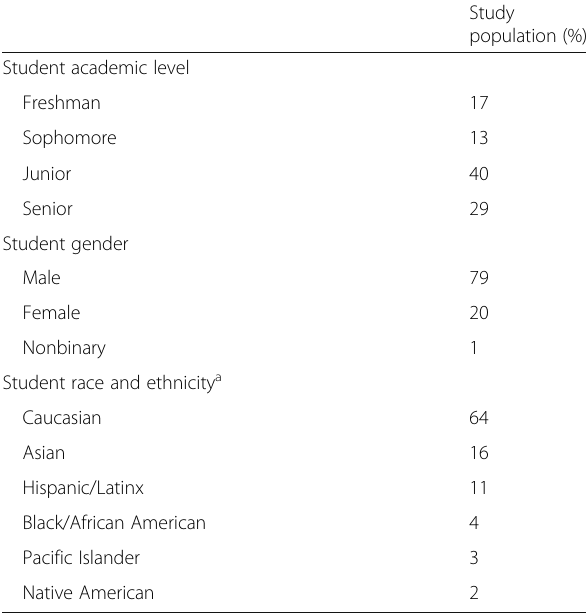
Table 2 Summary of student population